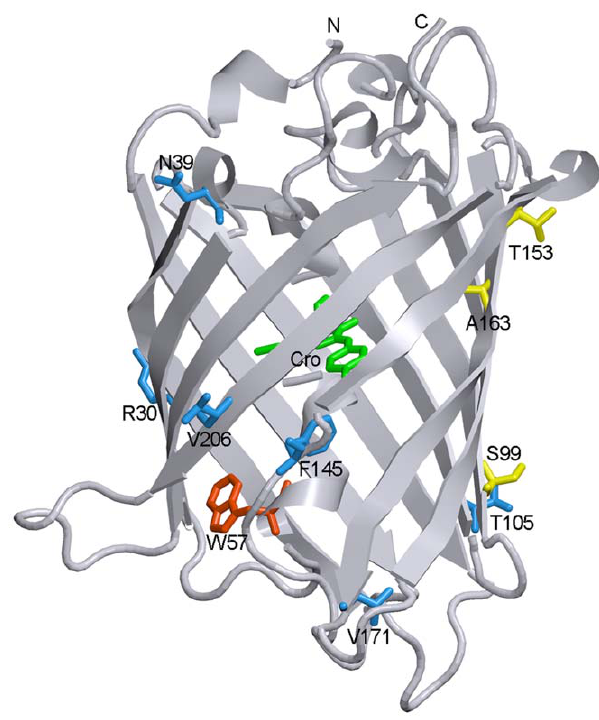
Figure 1. Spatial structure of sfGFP. The localizations of chromophore (green) and single tryptophan residue Trp 57 (red) are shown. Six amino acids which were mutated in the ’cycle-3’ GFP variant to yield sfGFP (S30R, Y39N, N105T, Y145F, I171V and A206V) are drawn as blue stick unions. The amino acids corresponding to the ’cycle-3’ mutations F99S, M153T and V163A are shown as yellow stick unions. The figure is created on the basis of PDB data [38] with the files 2B3P.ent for sfGFP [35], using the graphical software VMD [69] and Raster 3D [70].